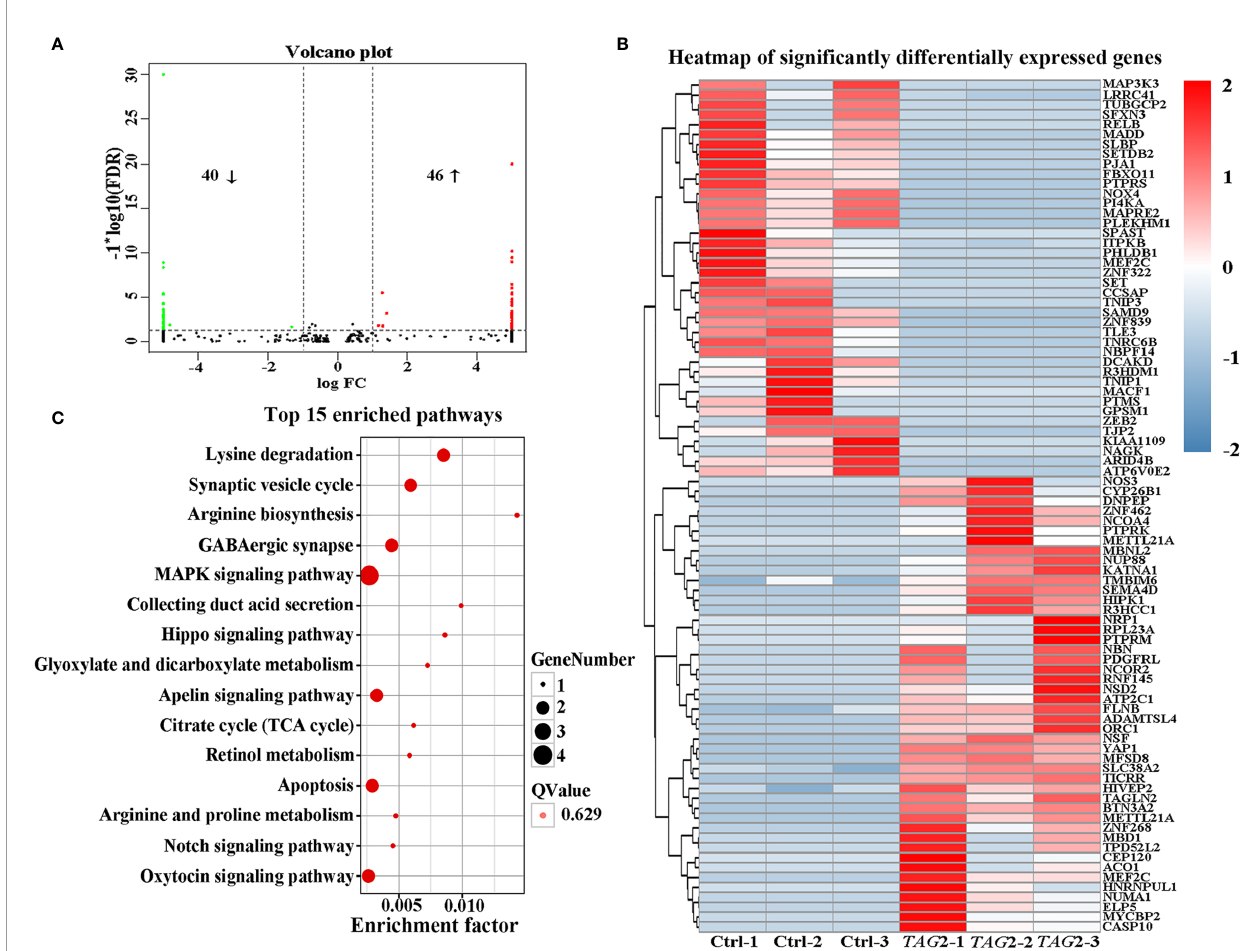
FIGURE 3 | Identi fi cation the potential mechanism involved in the proangiogenic activity of Tagln2 by RNA-Seq analyses. Primary HUVECs infected with lentiviral expression vector directing the expression of TAGLN2 or with mock vectors were prepared. mRNA libraries were sequenced on an Illumina sequencing platform, and bioinformatic analysis was performed by Genedenovo Biotechnology Co., Ltd. (Guangzhou, China). DEGs were identi fi ed with two criteria: a false discovery rate (FDR) of < 0.05 and a |log 2 fold change| of > 1. A volcano plot (A) , heatmap (B) and top15 KEGG pathways enriched in the signi fi cant DEGs identi fi ed by RNA-Seq (C) were